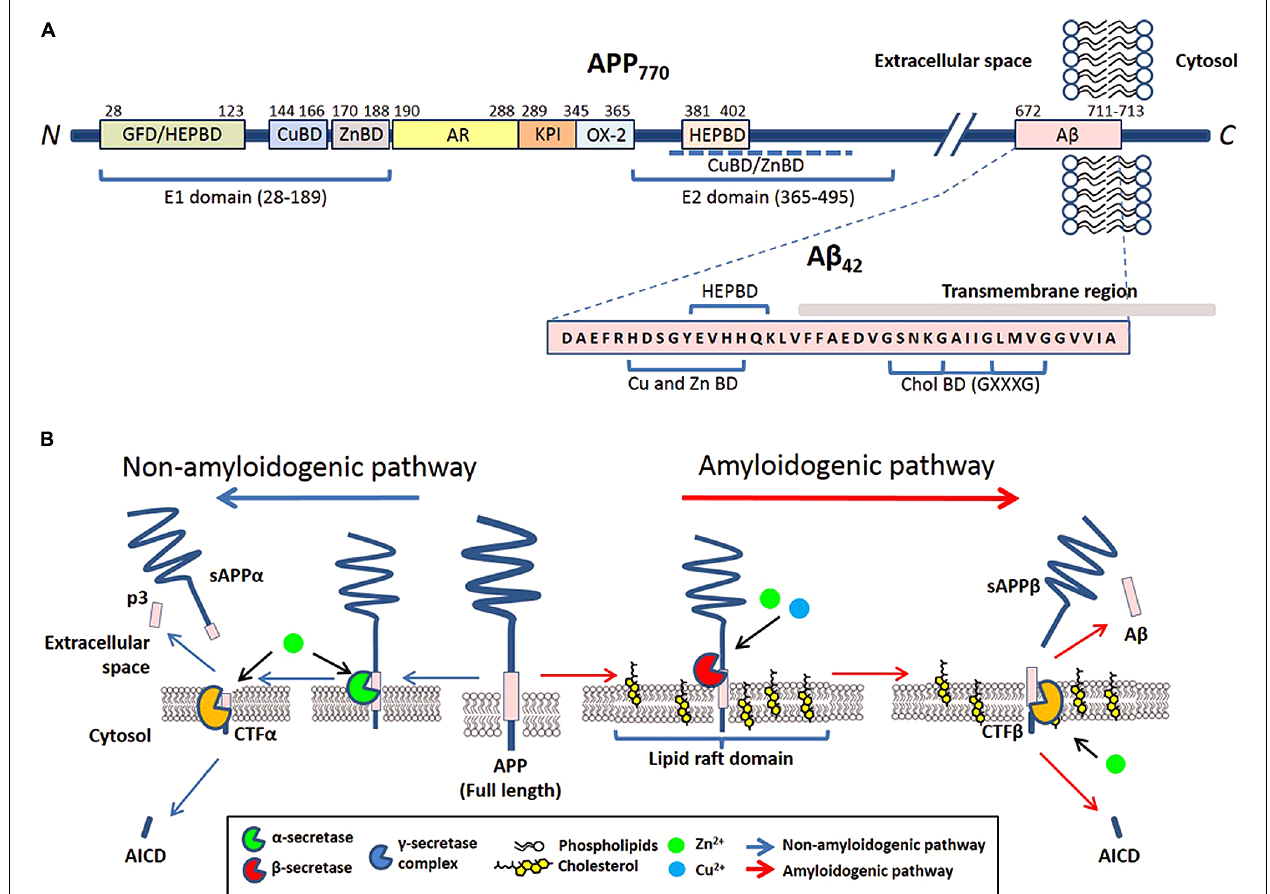
FIGURE 1 |The involvement of metals and cholesterol in post-translational modification ofAPP. (A) Schematic of reported metal and cholesterol binding domains in APP 770 and A β in relation to other recognized motifs. APP 770 is the longest isoform of APP with the APP 751 isoform lacking the OX-2 domain and the neuron prevalent isoform APP 695 lacking both OX-2 and Kunitz-type protease inhibitor (KPI).Within the extracellular presented ectodomain of APP, the E1 region at the N-terminal contains a copper binding domain (CuBD) and zinc binding domain (ZnBD) that is C-terminally orientated compared to the growth factor domain (GFD) which incorporates a heparin binding domain (HEPBD).The E1 domain is followed by the acidic region (AR), KPI and OX-2 before the E2 domain of APP, containing a HEPBD and CuBD/ZnBD that is yet to be exactly mapped (Dahms etal., 2012).The E2 domain is followed by the A β peptide that is partially embedded into the transmembrane region. A β also has a recognized CuBD/ZnBD as well as a